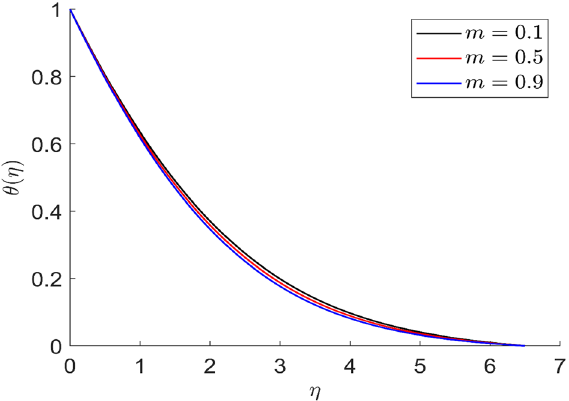
Figure 8. Representation of temperature θ(η) for the different values of m with R = 3, n = 3, v = 0.1, φ = 0.2, Pr = 0.6, φ 1 = 0.4, φ 2 = 0.8, β 3 = 0.5, β = 0.4, β 1 = 0.5, β 2 = 0.9, u = 0.2, ξ = 0.2.